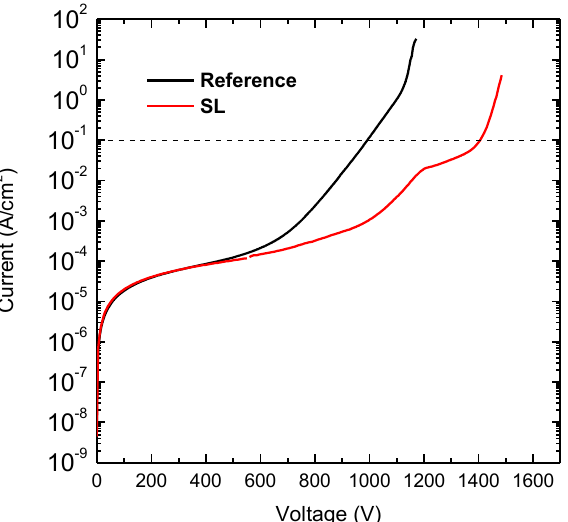
Figure 2. Vertical breakdown voltage at room temperature for the sample with and without superlattice (SL).